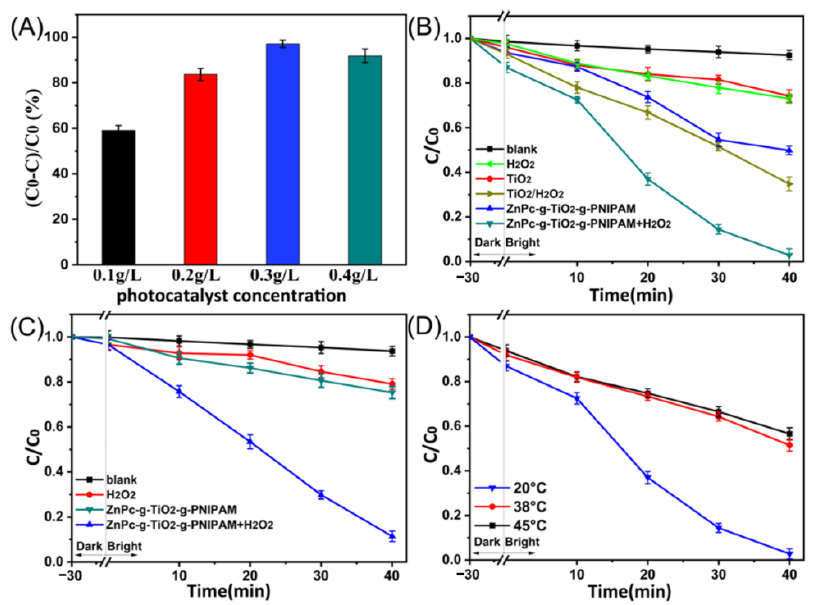
Figure 6. Photocatalytic efficiency of ZnPc -g- TiO 2 -g- PNIPAM/H 2 O 2 with different amounts of ZnPc -g- TiO 2 -g- PNIPAM for RhB (4.8 mg/L) removal at 20 °C under visible light in 40 min ( A ), the removal of RhB (4.8 mg/L) ( B ) and MB (8.0 mg/L) ( C ) with prepared samples at 20 °C under visible light, photocatalytic efficiency of ZnPc -g- TiO 2 -g- PNIPAM/H 2 O 2 (0.3 g/L) for RhB (4.8 mg/L) removal at different temperatures under visible light ( D ).